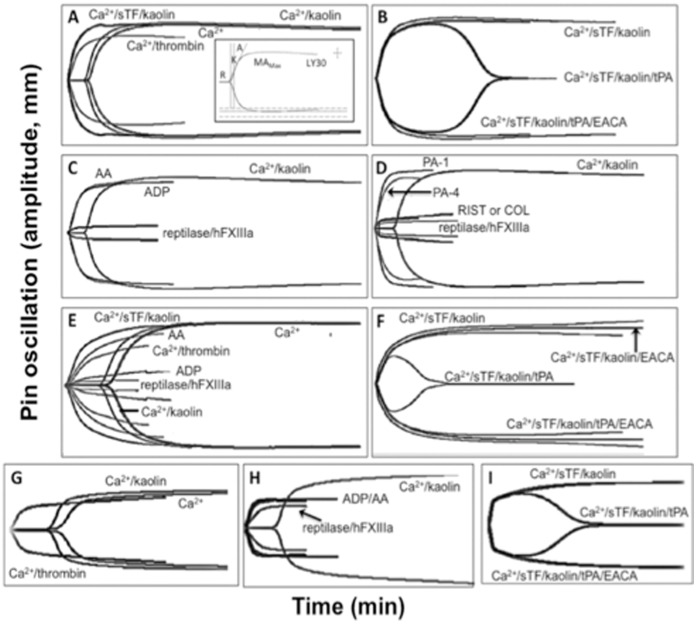
Representative TEG traces of human whole blood.(A–D) Representative normal control. Samples were collected in citrate-containing plastic tubes for additions of (A) Ca2+, Ca2+/kaolin, Ca2+/sTF/kaolin, or Ca2+/thrombin; (B) Ca2+/sTF/kaolin/tPA or Ca2+/sTF/kaolin/tPA/EACA, compared to the trace with Ca2+/sTF/kaolin/tPA. Samples were collected in heparin-containing plastic tubes and used for platelet stimulation of the MAF generated by (C) reptilase/hFXIIIa with AA or ADP; or (D) COL, RIST, PA-1, or PA-4. The MAmax obtained (from A) with Ca2+/kaolin was used as the 100% reference to compare all agonists for calculation of the degree of agonist stimulation. The inset in Figure 6A displays the parameters that were calculated by the software. (E-I) Similar measurements for (E, F) BSS-2 and (G-I) GT-1 whole blood, collected under the same conditions as normal control blood.